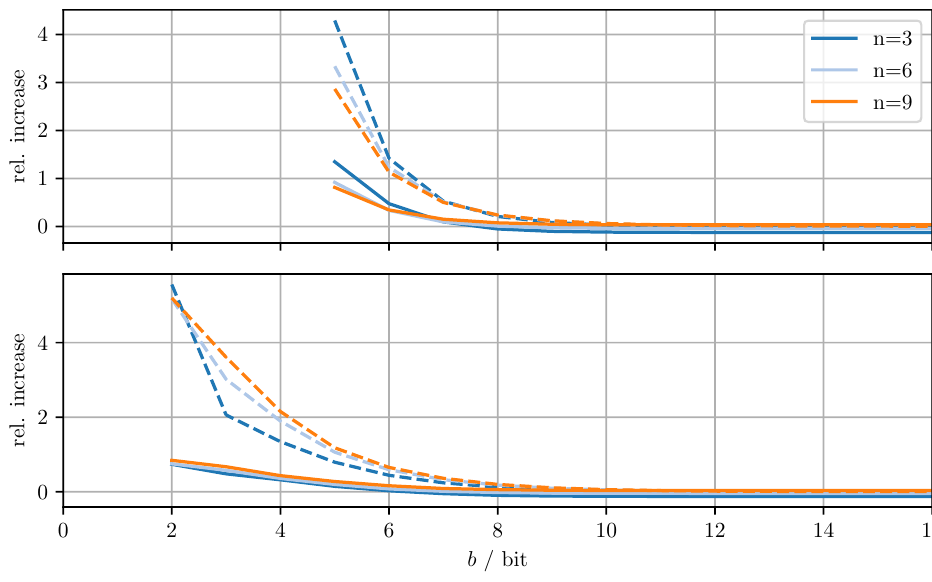
Figure 4. Relative increase of actual MSE (solid)/averaged trace (dashed) of DD-OPT with respect to OPT for varying dimensions n and bits per codeword b . Top row with quantized estimate vector and quantized error covariance, bottom row only with quantized error covariance.